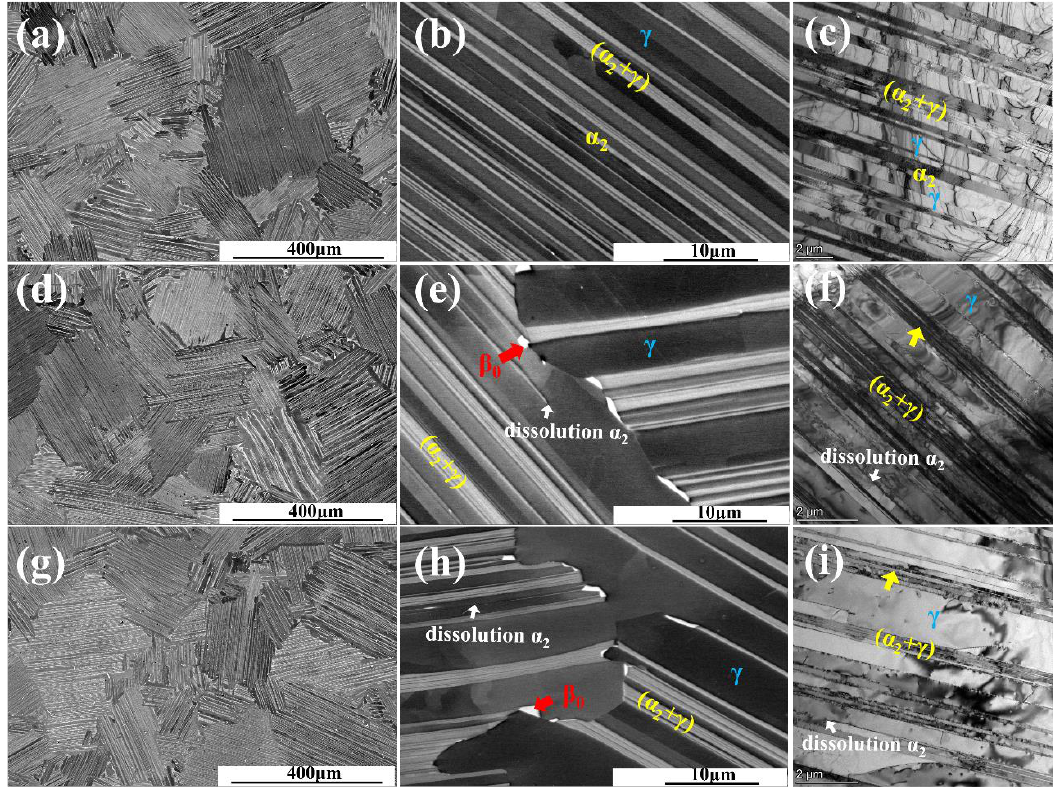
Figure 2. Microstructures of P-HIPed TNM alloys after different exposure treatments: ( a – c ) 750 °C/5 h/FC; ( d – f ) 800 °C/5 h/FC; ( g – i ) 850 °C/5 h/FC.